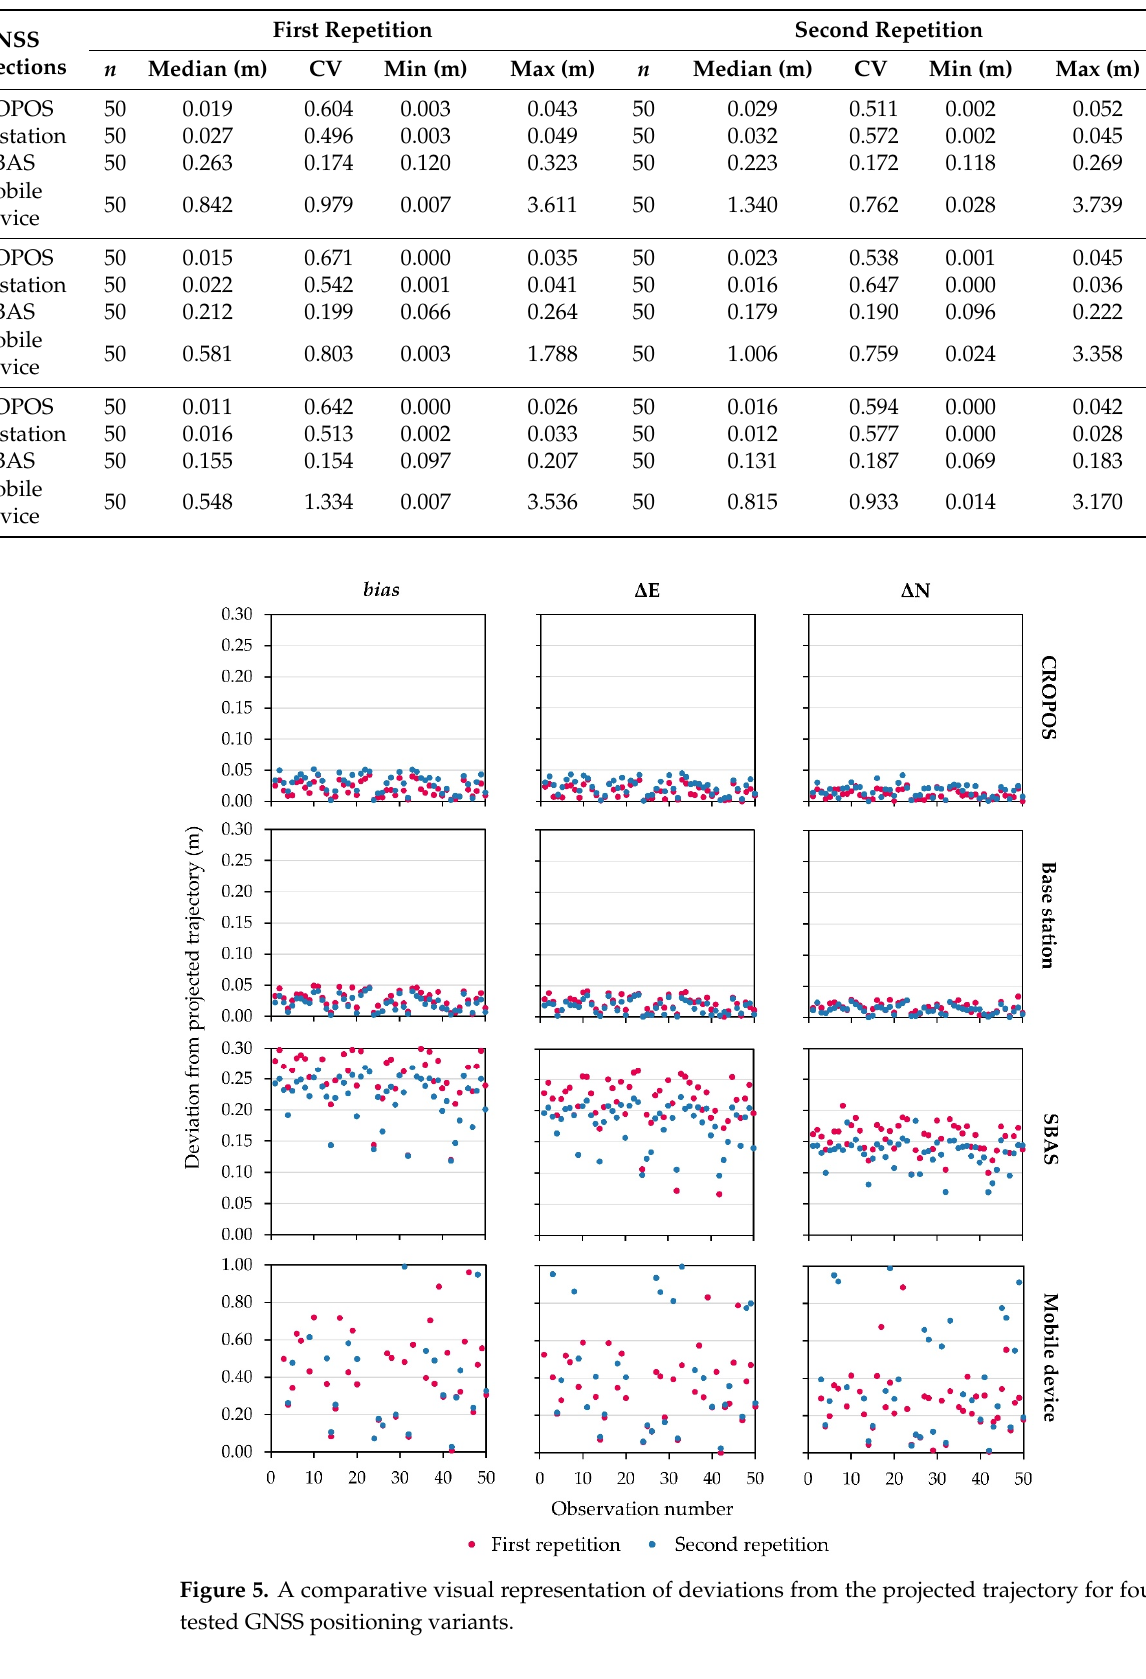
Table 2. Descriptive statistics of the bias produced by the used GNSS RTK corrections from the projected trajectory.